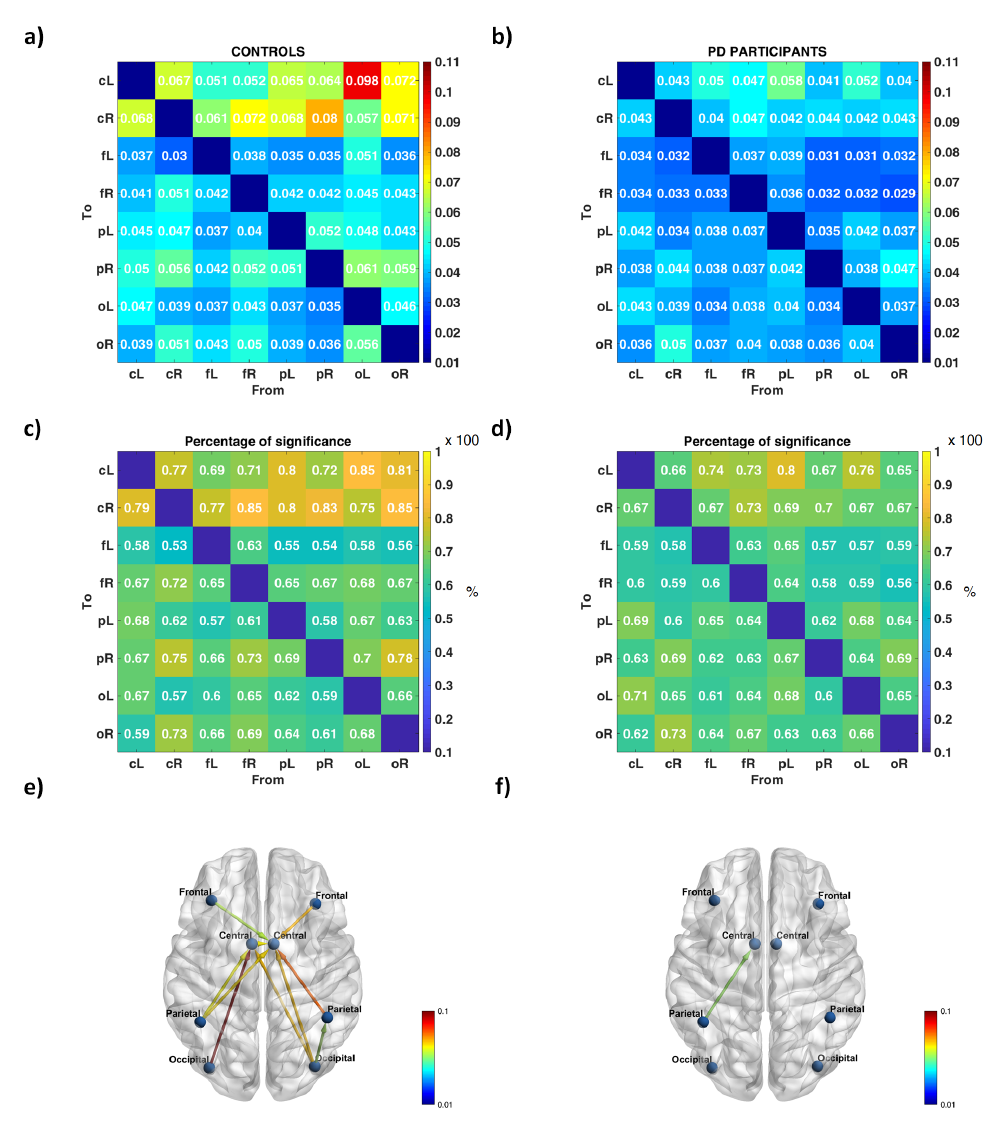
Figure 1. ( a , b ) Grand-average GC matrices for ( a ) controls and ( b ) PD participants. Element (i,j) - where i indicates the row and j the column - represents the weight of the connection from ROI j to ROI i. CR and cL denote central areas of right (R) and left (L) hemisphere, fR and fL frontal areas, pR and pL parietal areas and oR and oL occipital areas. The diagonal elements of the matrix are set to zero, since they represent connections from a ROI to itself (loops). ( c , d ) Grand-average percentage matrices for ( c ) controls ( d ) and PD participants: values in the matrix are reported as the result of the ratio, e.g., 0.77 = 77 which corresponds to 77%. Element (i,j) represents the percentage of epochs where the 100 connection from ROI j to ROI i was recognized as significant throughout the whole recording. ( e , f ) Connectivity networks for ( e ) controls and ( f ) PD participants. Only the most relevant connections are depicted, i.e., the ones recognized as significant in at least 79% of epochs. Circles stand for the eight ROIs and arrows for directed connections. Colorbars represent the magnitude of the brain